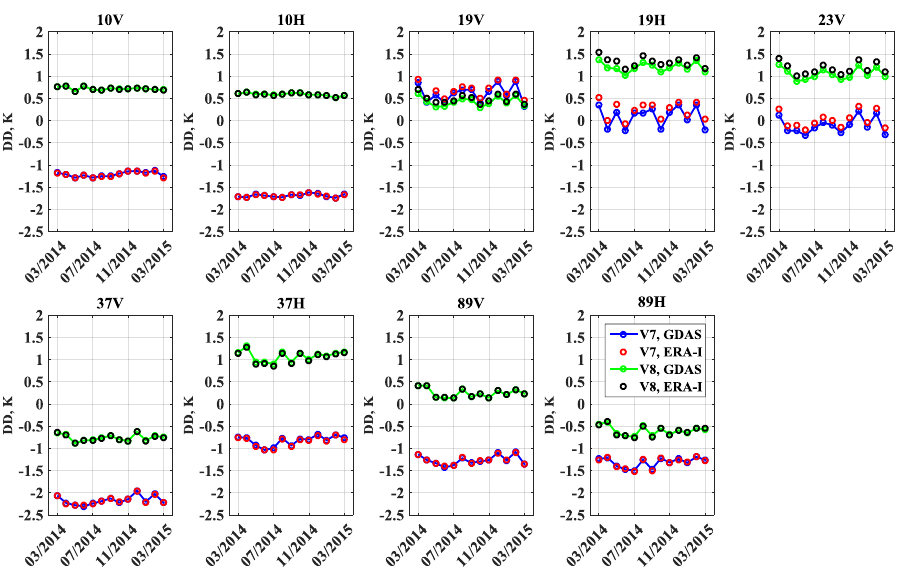
Figure 11. Monthly intercalibration double differences (DD) for TMI relative to GMI for four cases. Red line indicates monthly averaged DD using TMI V7 Tb and GDAS environmental data; blue is TMI V7 but with ERA-I; green is TMI V8 with GDAS and black is TMI V8 but with ERA-I data. Ideally, when the DD’s are separated into two yaw orientations, they should be identical.